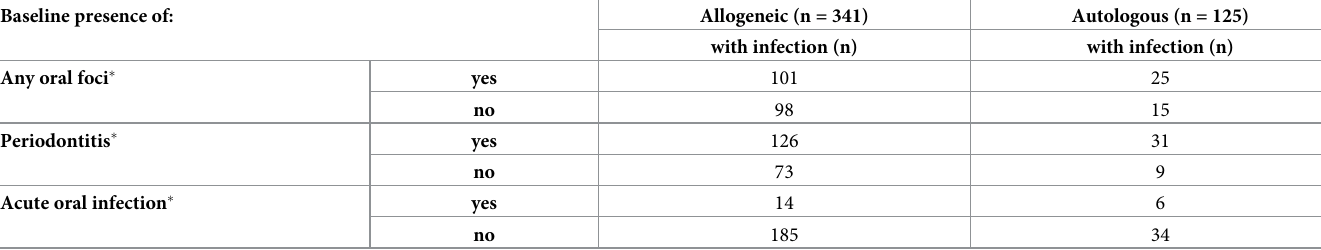
Table 3. Association of having chronic oral foci of infection with hospital treated infectious diseases 0–6 months post-HSCT. Baseline presence of: